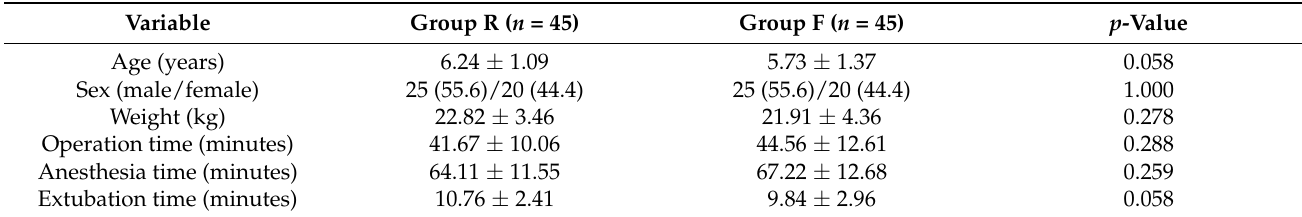
Table 1. Demographics and anesthetic data.